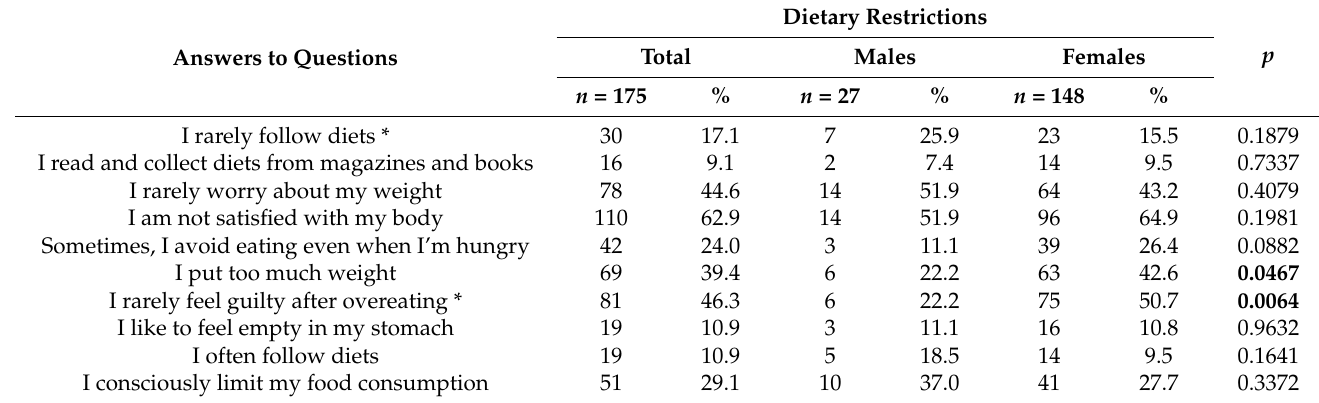
Table 8. Answers to questions on dietary restrictions in males and females.